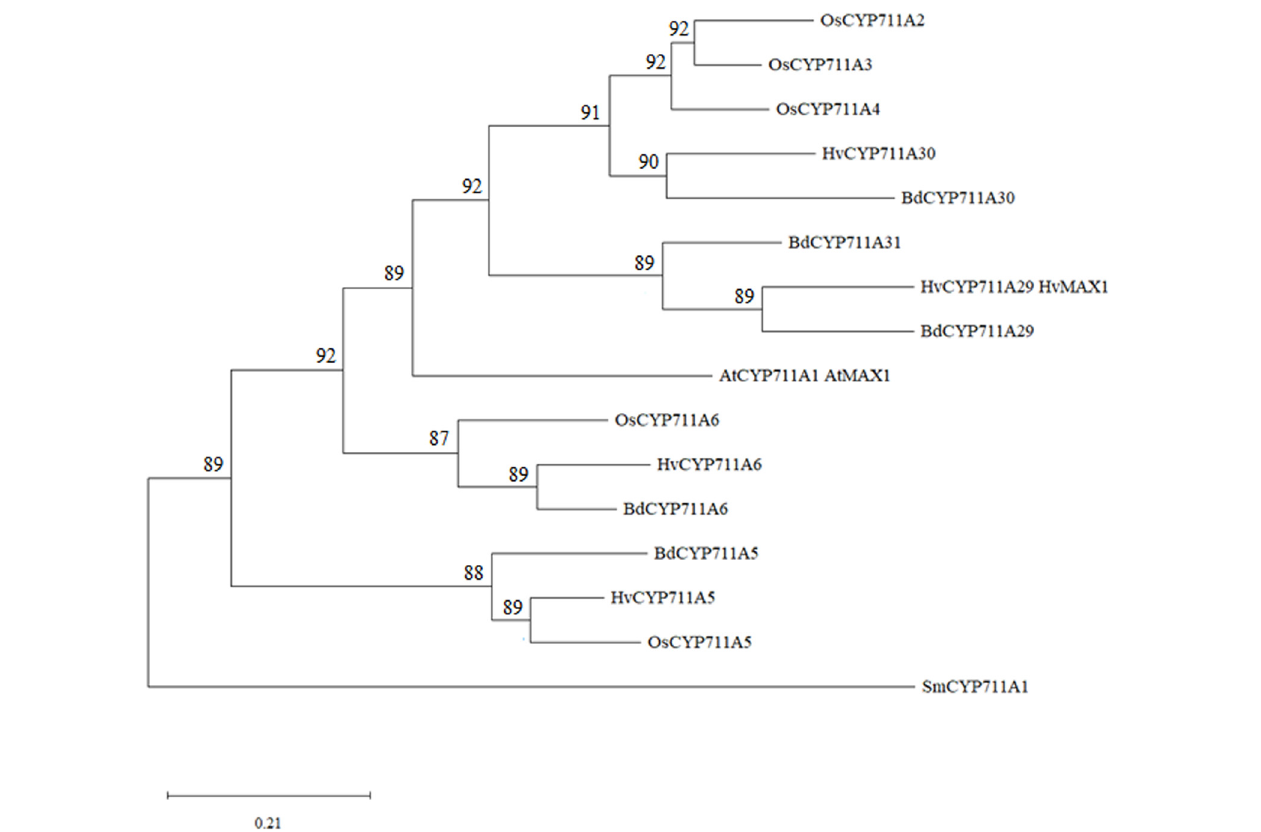
FIGURE 2 | Molecular phylogenetic analysis of A. thaliana , B. distachyon, H. vulgare , O. sativa , and S. moellendorffii CYP711As. The protein evolutionary history was inferred by using the Maximum Likelihood method based on the JTT matrix-based model (Jones et al., 1992). The bootstrap consensus tree inferred from 500 replicates (Felsenstein, 1985) is taken to represent the evolutionary history of the taxa analyzed (Felsenstein, 1985). Branches corresponding to partitions reproduced in less than 50% bootstrap replicates are collapsed. The percentage of replicate trees in which the associated taxa clustered together in the bootstrap test (500 replicates) are shown next to the branches (Felsenstein, 1985). Initial tree(s) for the heuristic search were obtained automatically by applying Neighbor-Join and BioNJ algorithms to a matrix of pairwise distances estimated using the JTT model, and then selecting the topology with superior log likelihood value. This analysis involved 16 amino acid sequences. There were a total of 567 positions in the final dataset. Evolutionary analyses were conducted in MEGA X (Kumar et al., 2018). The tree has been rooted with Selaginella moellendorffii CYP711A1 (SmCYP711A1). At: A. thaliana ; Bd: B. distachyon ; Hv: Hordeum vulgare ; Os: O. sativa; Sm: S. moellendorffii . Protein sequences used in this analysis are available under the following accession numbers: AtCYP711A1, OAP07831.1; BdCYP711A5, XP_003571126.1; BdCYP711A6: XP_003560652.1; BdCYP711A29, XP_003562092.2; BdCYP711A30: XP_003575594.2; BdCYP711A31, XP_010237353.2; HvCYP711A5, BAJ97619.1; HvCYP711A6, KAE87888859.1; HVCYP711A29, BAJ98237.1; HvCYP711A30, KAE8810993.1; OsCYP711A2, XP_015633367.1; OsCYP711A3, XP_015644699.2; OsCYP711A4, XP_015642272.1; OsCYP711A5, XP_015626073.1; OsCYP711A6, XP_015644019.1;